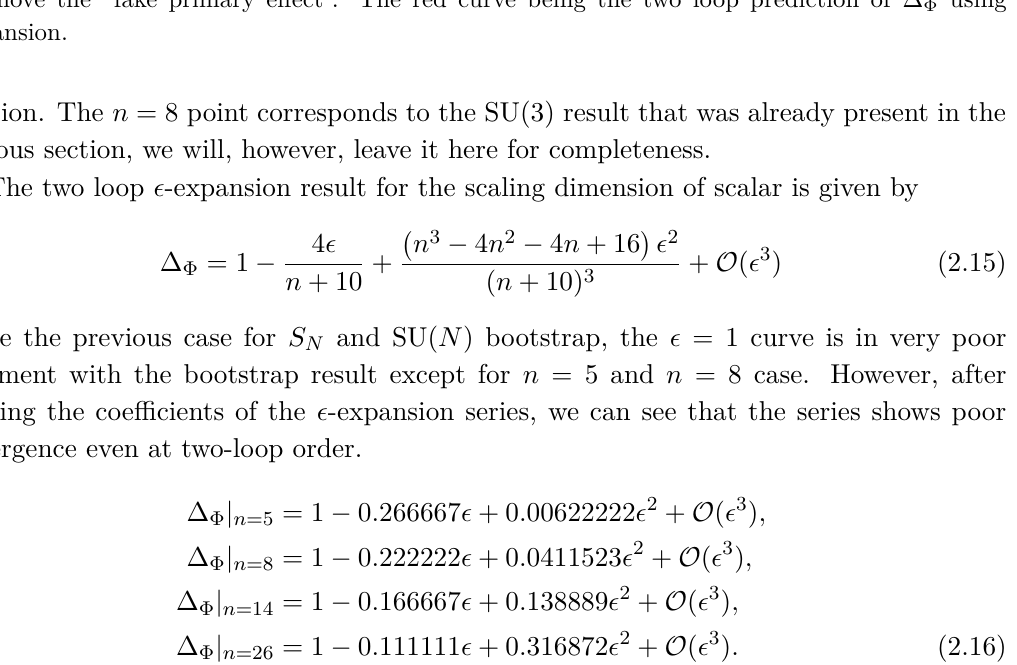
as a Φ ≥ ∆ unitarity + 1 . 2 F j =1 / 2 + ,n using Φ